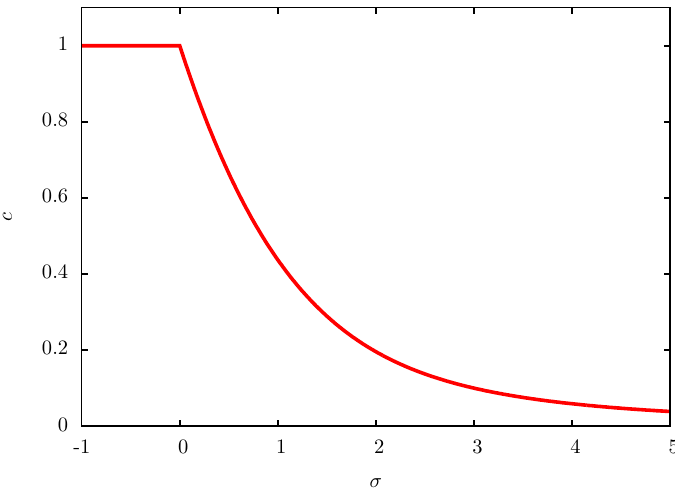
Figure 2: Isostaticity index c on the jamming line, computed on the RS solution for σ ≥ 0,